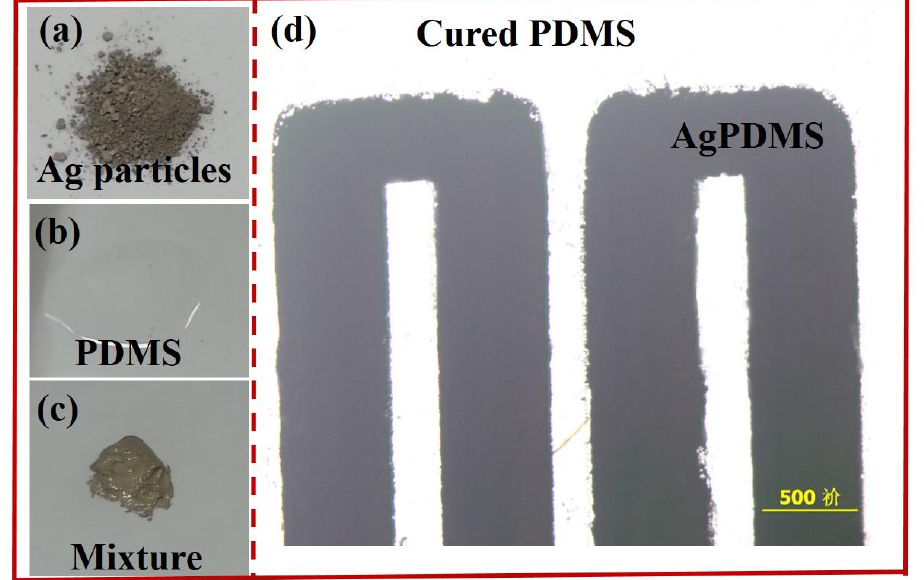
Figure 1. ( a ) The silver submicron particles; ( b ) PDMS pre-polymer; ( c ) The mixture of silver particles and PDMS gel; ( d ) Picture of conductive circuit with PDMS-based conducting composite (AgPDMS) on a pure PDMS slab (transparent